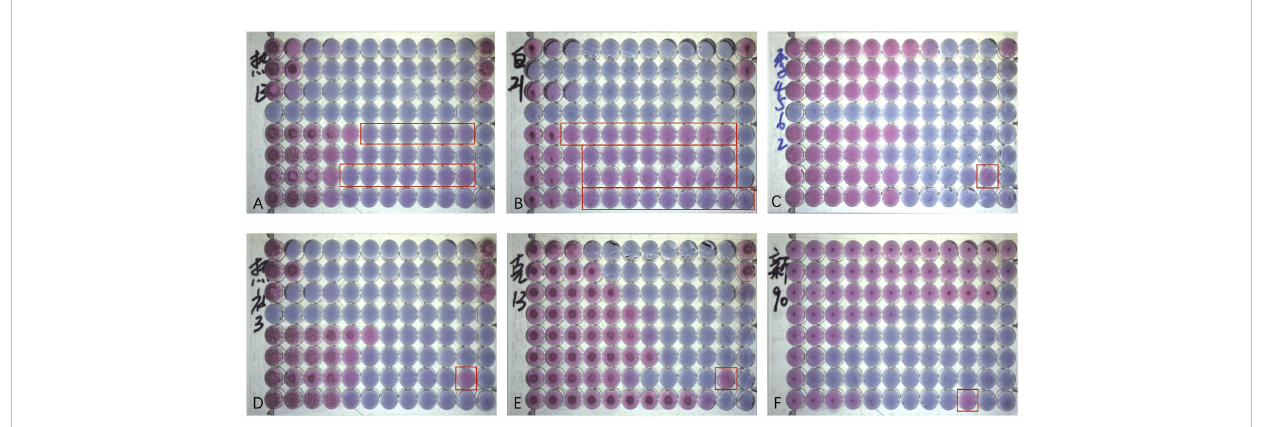
FIGURE 5 Antifungal Susceptibility Testing using Sensititre YeastOne (SYO) colorimetric antifungal panel (Thermo Fisher Scienti fi c). (A) Weak “ trailing growth ” of posaconazole and itraconazole in Candida tropicalis . (B) Heavy “ trailing growth ” of posaconazole, voriconazole, itraconazole, and fl uconazole in Candida albicans ; (C) “ Eagle effect ” with itraconazole in Candida guilliermondii ; (D) "Eagle effect" with itraconazole in Candida tropicalis. (E) “ Eagle effect ” with itraconazole in Candida krusei ; and (F) “ Eagle effect ” with fl uconazole in Cryptococcus neoforman